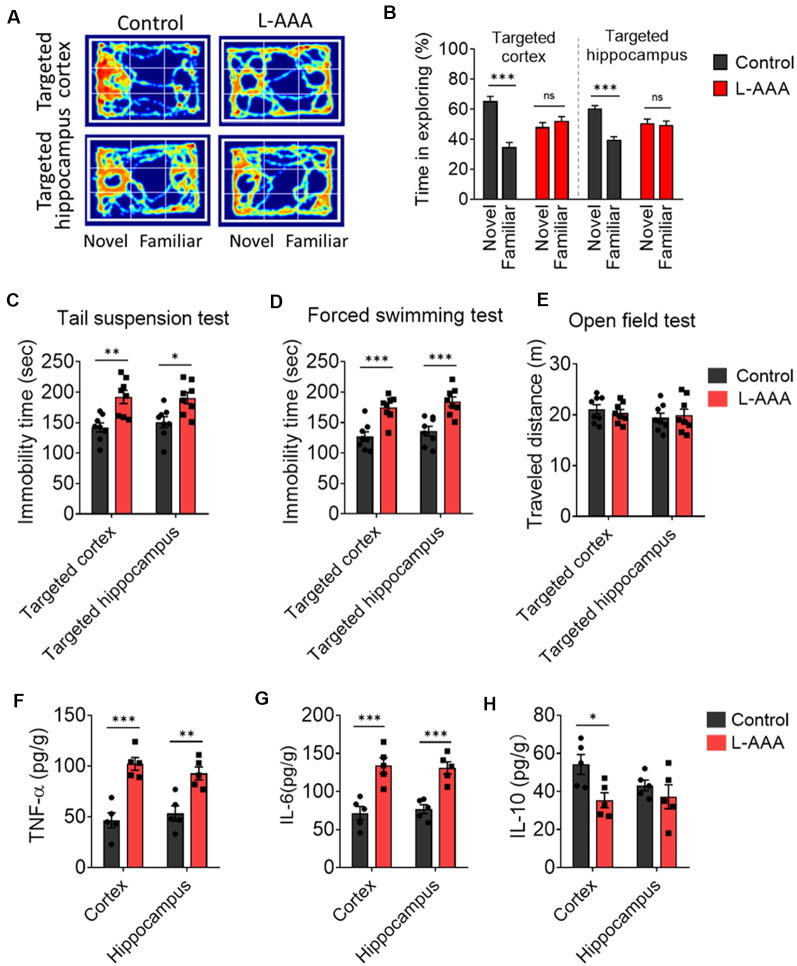
Ablation of astrocytes results in depressive-like behaviors, cognitive impairs, and neuroinflammation. (A,B) The novel object recognition test was used to evaluate cognitive function. Results in panels (B) reflect the results of 8–9 mice per group. Data are mean ± SEM. ***p < 0.005; unpaired t-test. (C–E) Depressive-like behaviors were measured in the (C) tail suspension test, (D) forced swimming test, (E) open-field test. Results in panels (C–E) reflect the results of eight mice per group. (F–H) Protein expression of inflammatory cytokines (TNF-α, IL-6, and IL-10) in the cortex and hippocampus. Results in panels (F–H) reflect the results of five mice per group. Data are mean ± SEM. *p < 0.05, **p < 0.01, ***p < 0.005; two-way ANOVA. ns: not significant (p > 0.05).